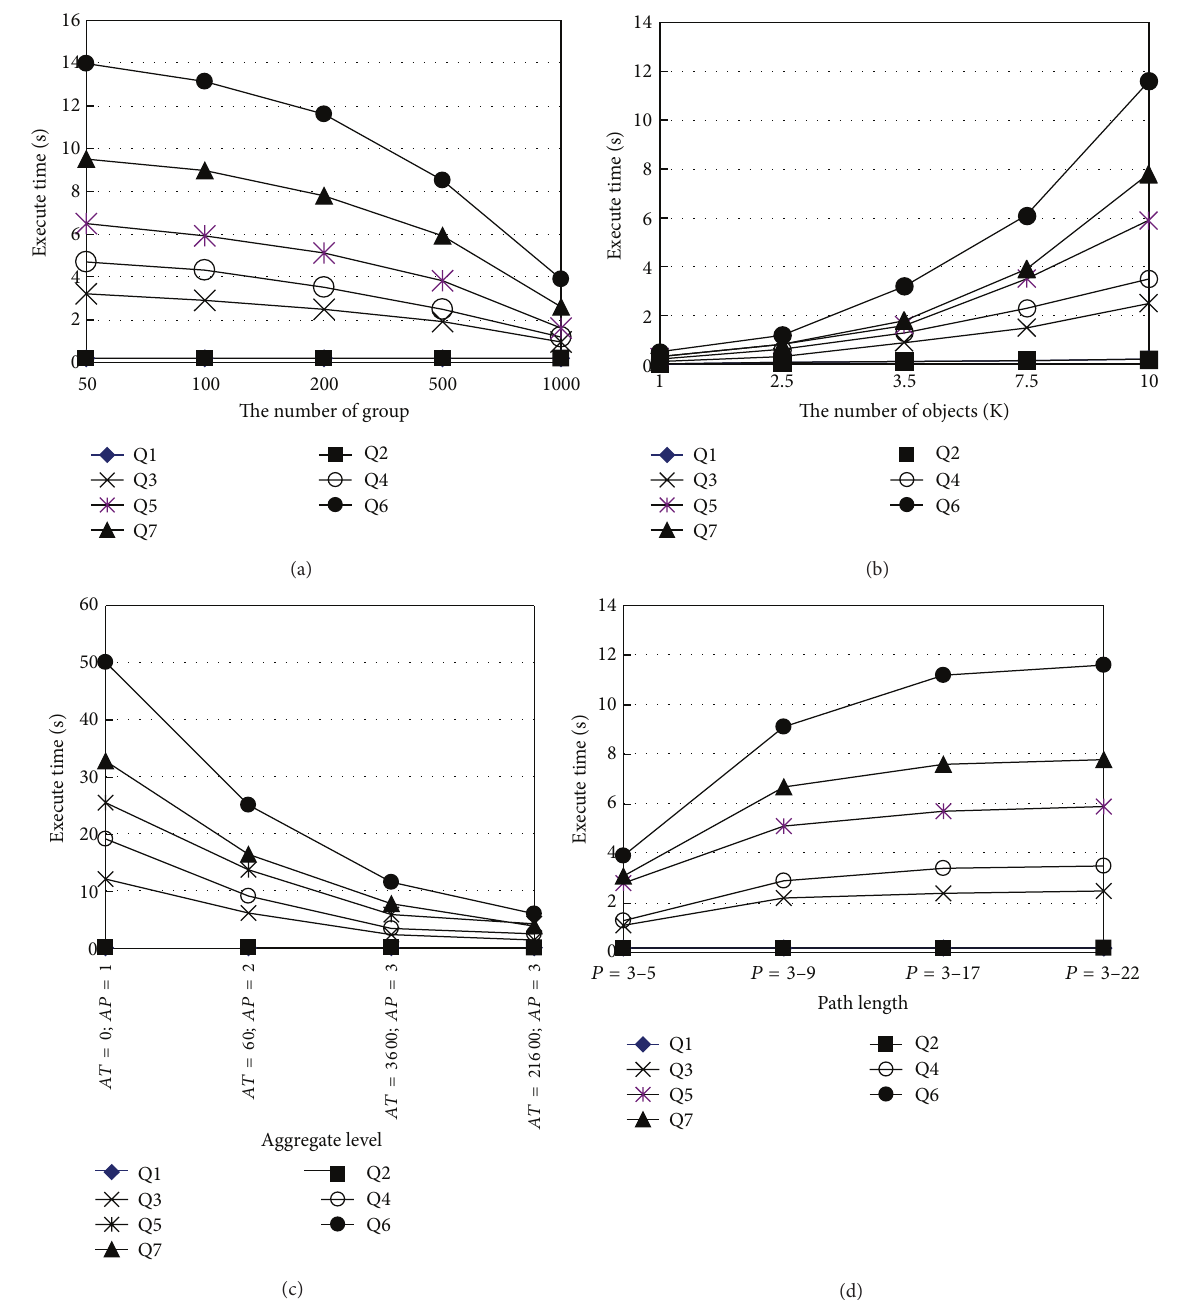
Figure11:(a)Differentnumberofgroupings.(b)Differentdatasizes.(c)Differentaggregatelevelsofpositionsandtimeintervals.(d)Different path